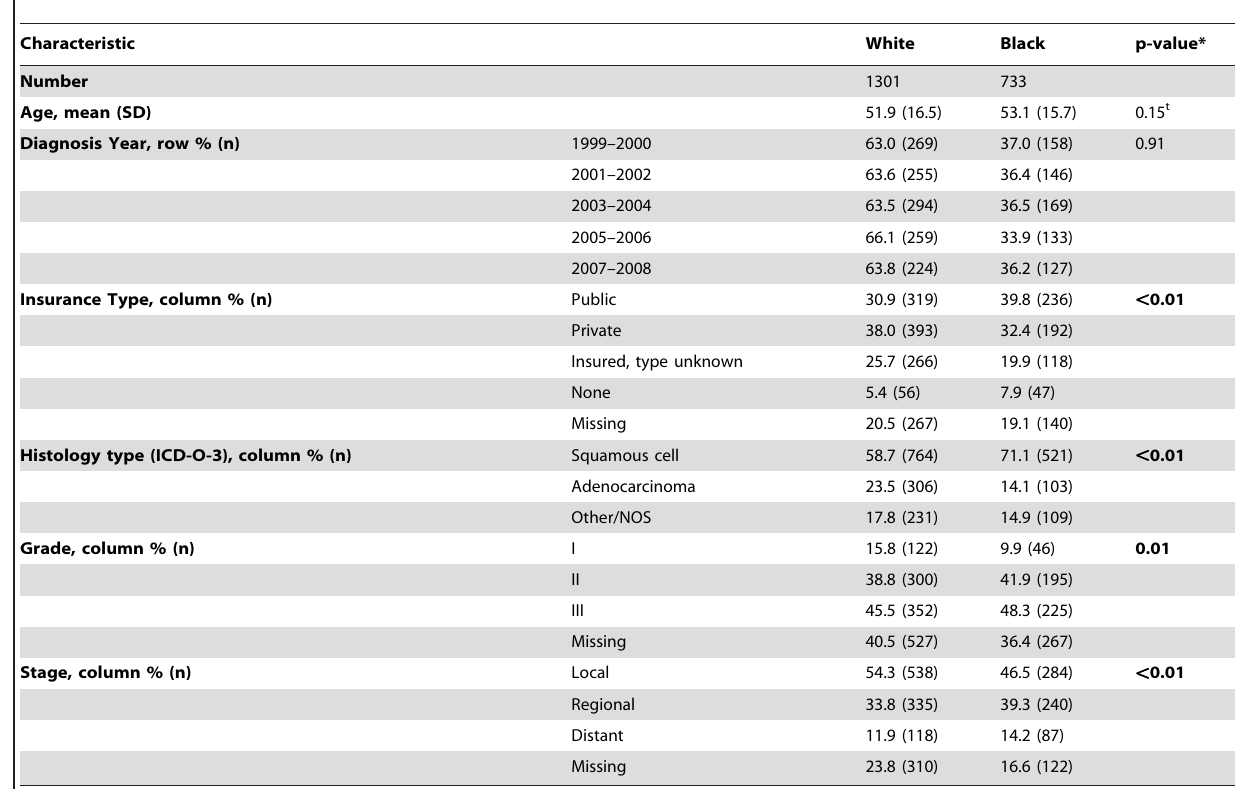
Table 1. Patient characteristics between